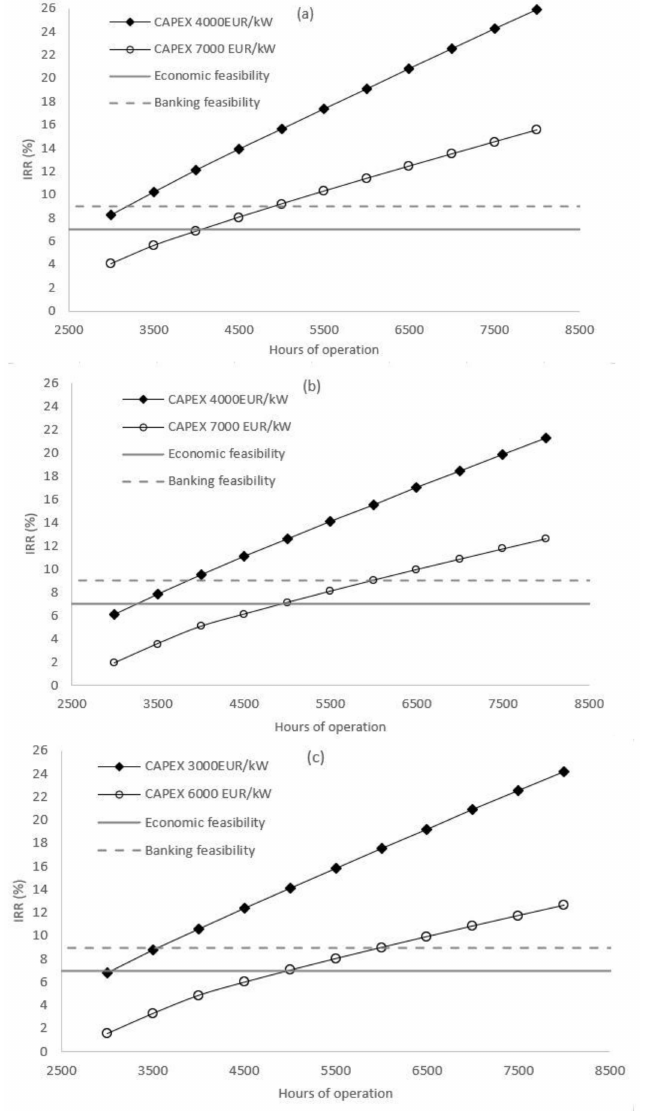
Figure 5. Internal rate of return vs. hours of operation for plants of 250 kW with an incentive of 0.219 EUR/kWh ( a ), 500 kW with an incentive of 0.179 EUR/kWh ( b ), 1000 kW with incentives of 0.156 EUR /kWh ( c